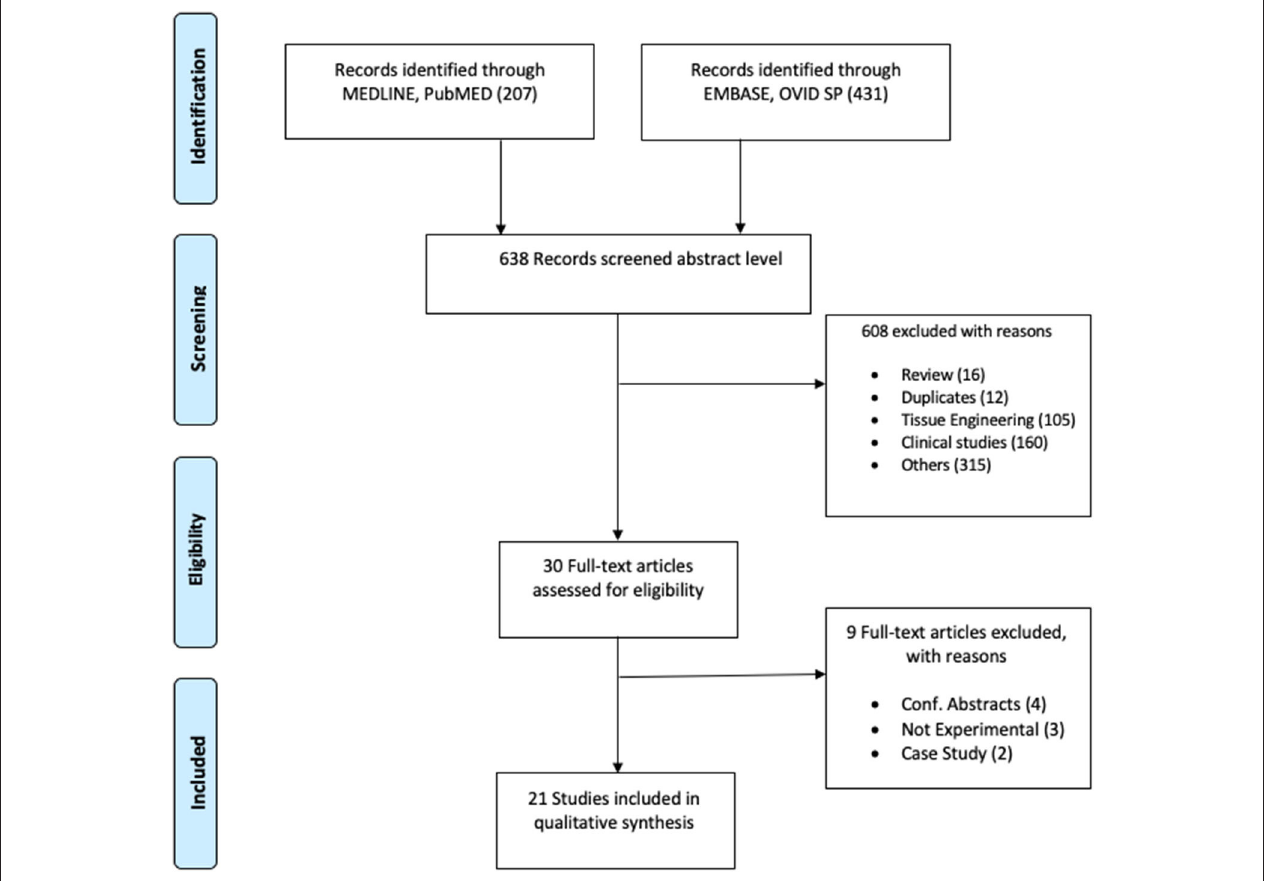
FIGURE 1 | Flowchart of the articles distinguished, included, and